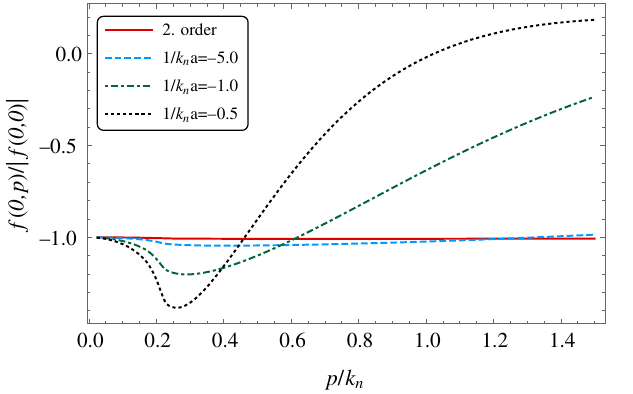
FIG. 3. The Landau effective interaction f ð 0 ; p Þ for unit mass ¼ 1 , vanishing impurity concentration, zero temper- ratio m=m B ¼ 0 . 2 , and various impurity-boson scattering lengths. a ature, k n B The second-order perturbative results are also plotted.